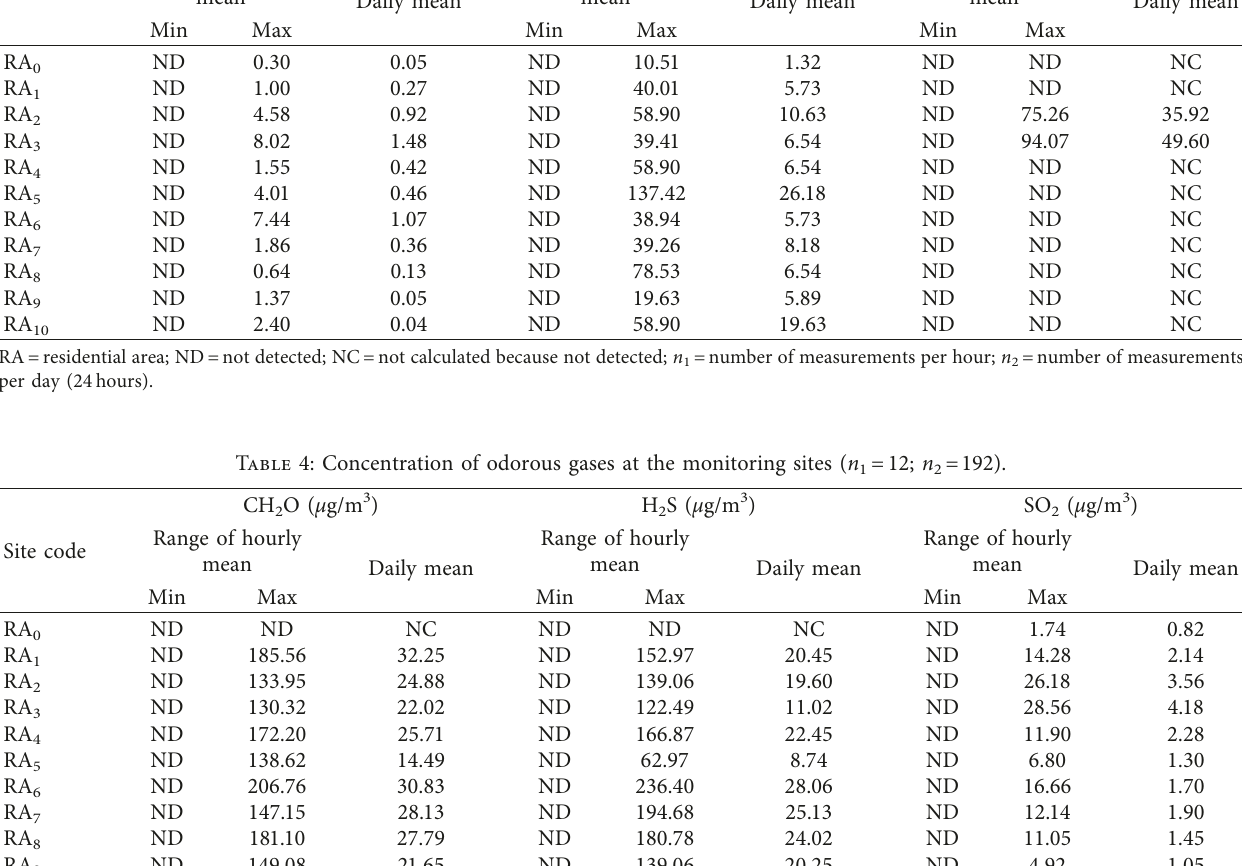
Table 3: Concentration of odourless gases at the monitoring sites ( n